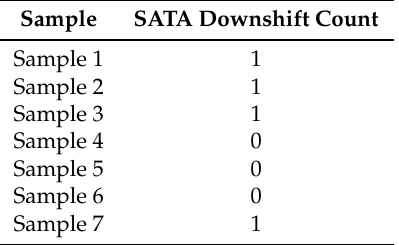
Table 7. SATA Downshift